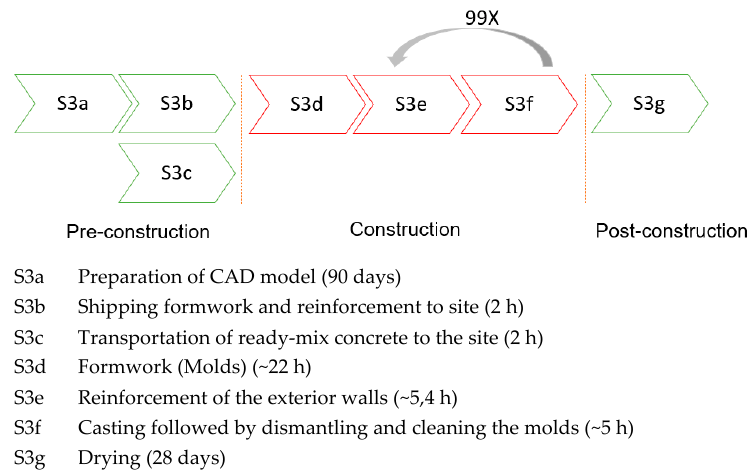
Figure 5. The process map for Scenario 3.